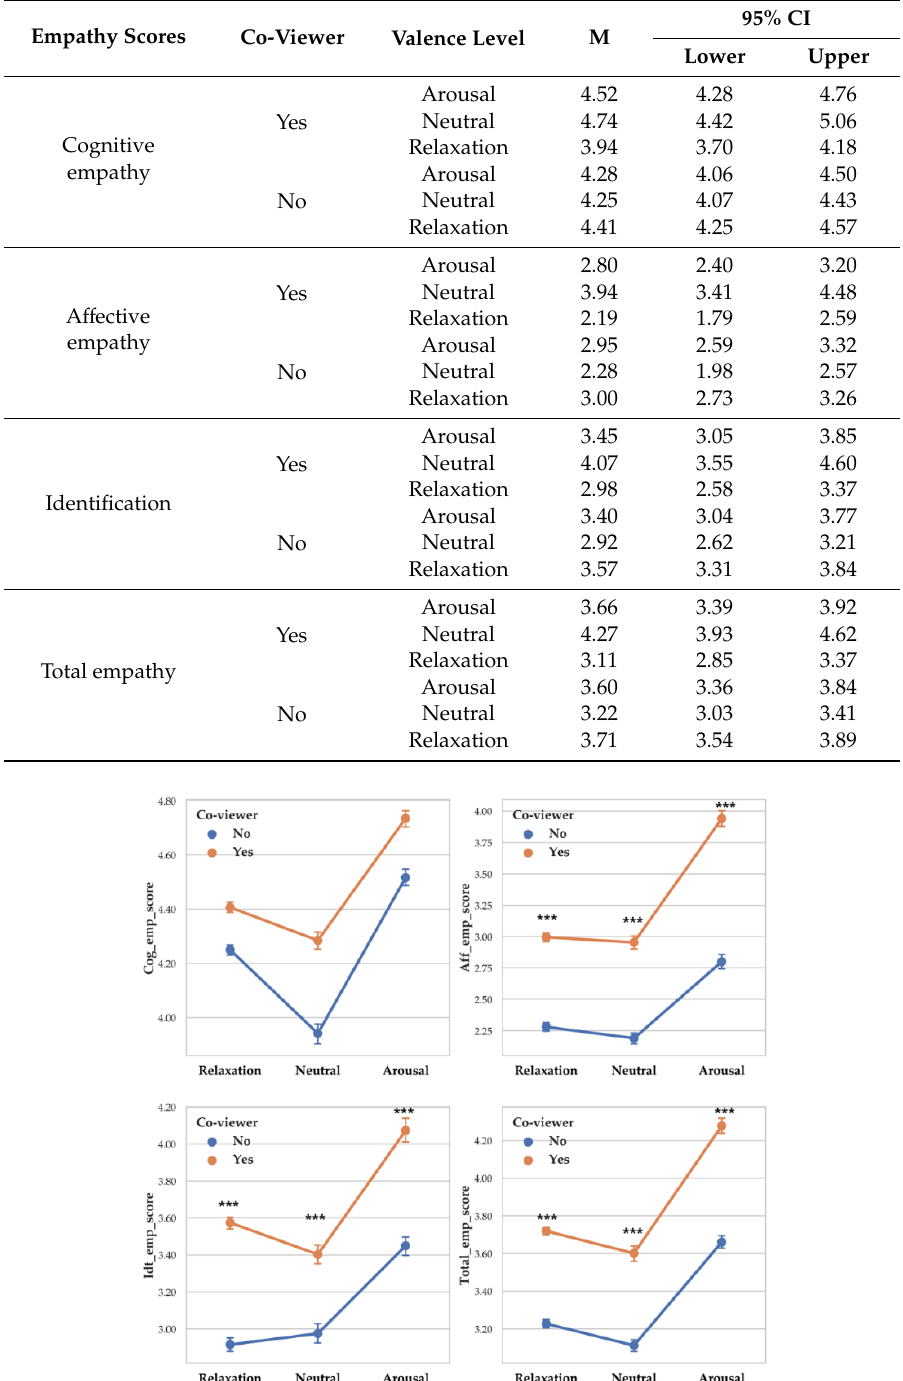
Figure 13. Point graph of self-report empathy depending on co-viewer condition and arousal level. ‘Co-viewer no’ means participants without co-viewer. ‘Co-viewer yes’ means participants with co-viewers. Asterisk means significant empathy score difference according to co-viewer condition. (***: p < 0.001).